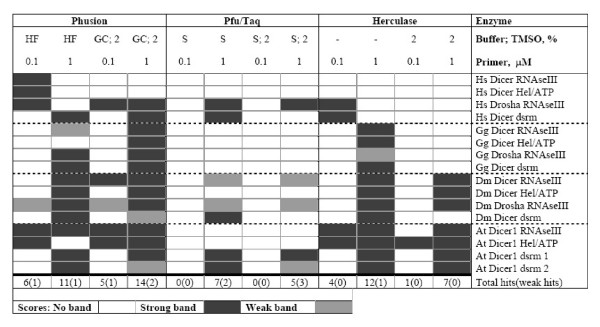
Result summary of gel electrophoreses with PCR products. Pictures of the gels were taken after staining with ethidium bromide. They were visually inspected and bands with suitable DNA size were scored (cf. fig. 2). Species identifiers: Hs, Homo sapiens; Gg, Gallus gallus (chicken); Dm, Drsosophila melanogaster; At, Arabidopsis thaliana. Domain abbreviations: Hel, helicase; ATP, ATPase, dsrm, double-stranded RNA-binding motiv. Designations: Species identifier, protein name, short designation of target domain(s).